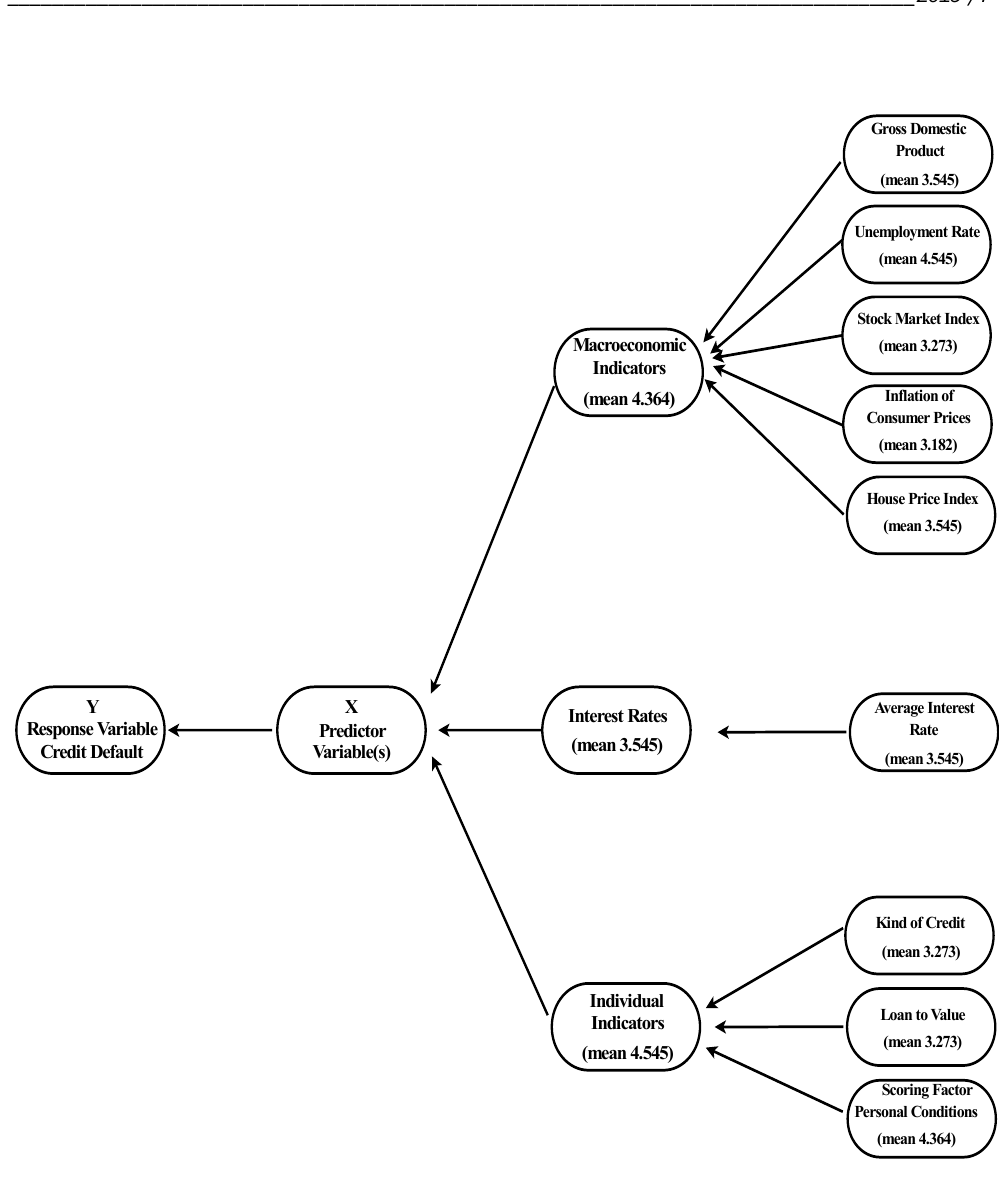
Fig. 6. Results of bank survey for the German market (developed by the author). The main findings of the second research approach for RQ3 are as follows: − The personal situation of the borrower has the largest influence on the credit defaults with a mean of 4.545. − The scoring factor of the borrower is that borrower indicator with the most significant influence on the credit defaults with a mean of 4.364, which is followed by the type of chosen mortgage and loan-to-value ratio, both with a mean of